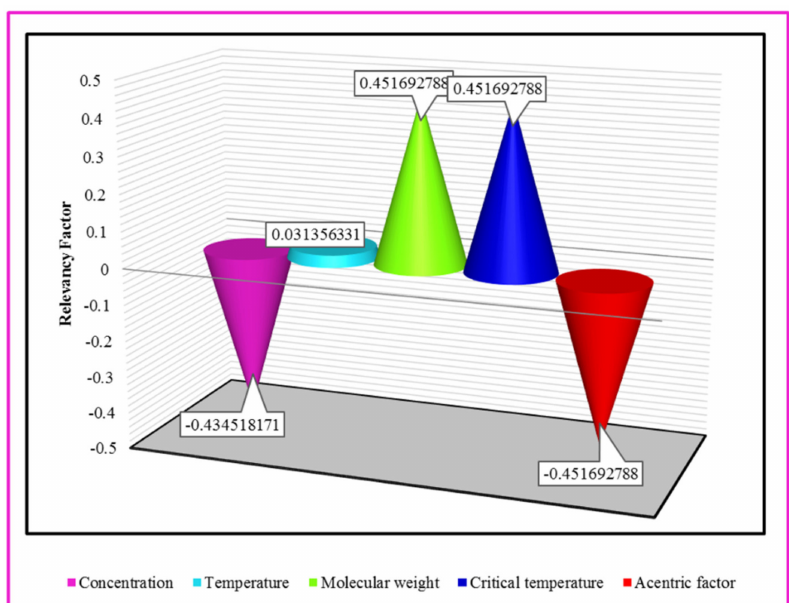
Figure 7. Sensitivity analysis to determine the e ff ect of the inputs on the C p values of